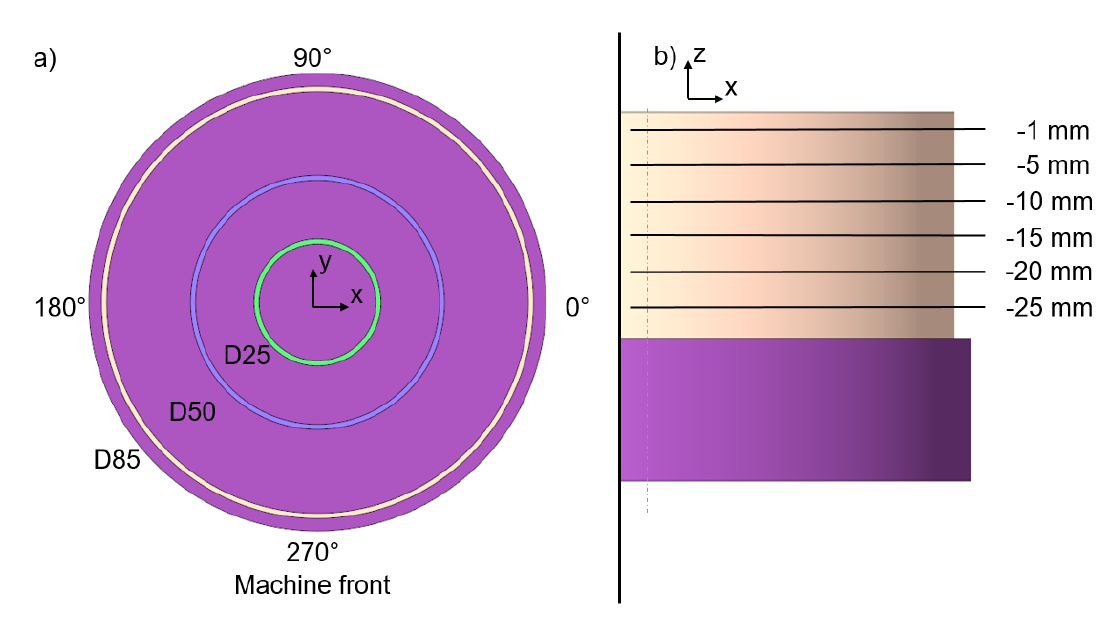
Figure 2. Two-dimensional views of ( a ) specimen position on building plate with angles and ( b ) dimensions for tactile measurements of distortion.